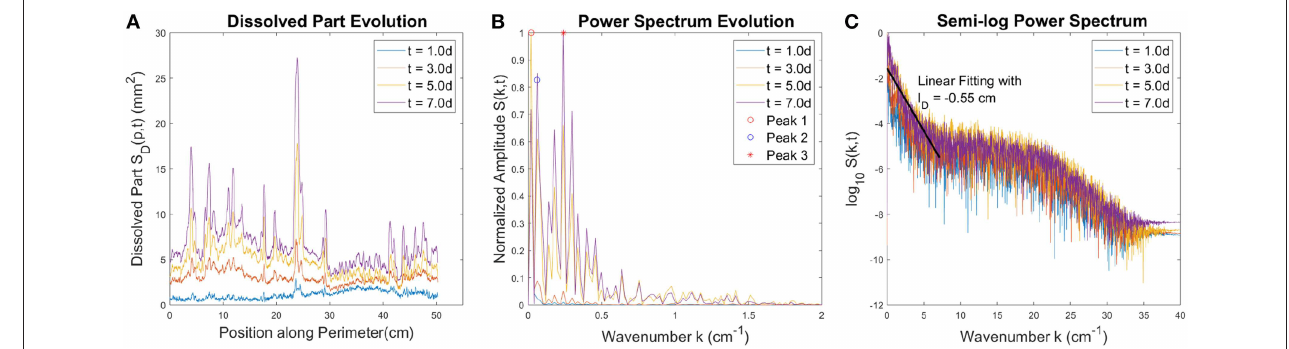
FIGURE 8 | (A) The local dissolved part S D ( p , t ) at different time moments. (B) The power spectrum of S D ( p , t ) profiles presented in (A) . Three main peaks are indicated in the plot. The first two (marked by red and blue circles) are related to the initial geometry of the plaster sample. On the other hand, the peak at 0.24 cm − 1 with wavelength ∼ 4.2 cm (marked by the red star) is related to the characteristic wavelength of the fingering pattern. (C) Semi-log plot of the power spectrum, which allows to observe power amplitude trends in a larger scope. The amplitude decays almost exponentially with wavenumber at low wavenumber (high wavelength), followed by a flat plateau at higher wavenumbers. The solid black line in (C) is the linear fit, the slope of which gives the characteristic decay length, l D = 0.55 cm .